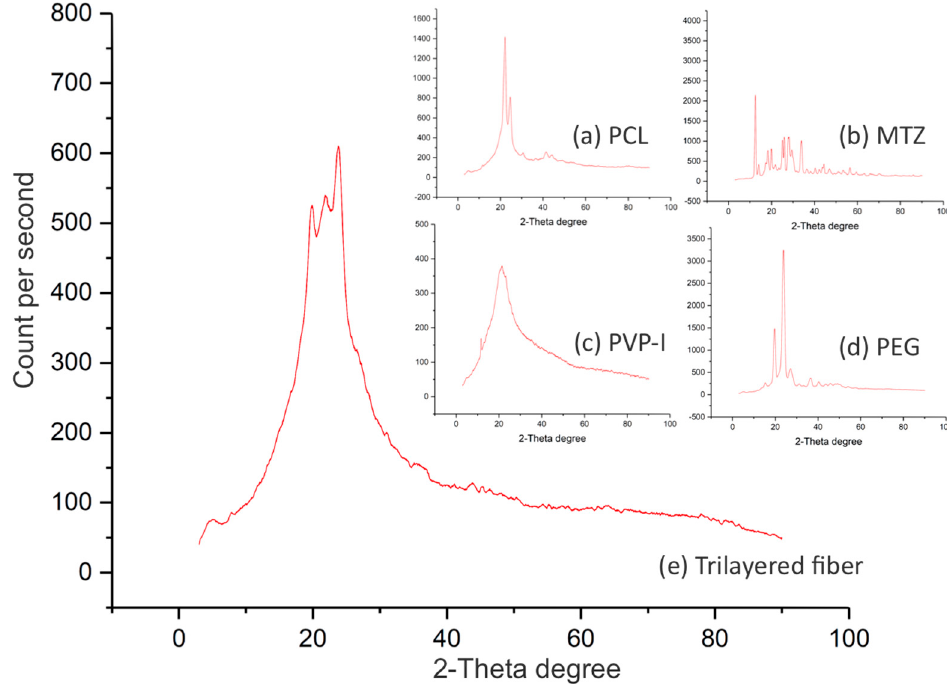
Figure 5. XRD patterns for ( a ) PCL, ( b ) MTZ, ( c ) PVP-I, ( d ) PEG and ( e ) fiber. XRD patterns of